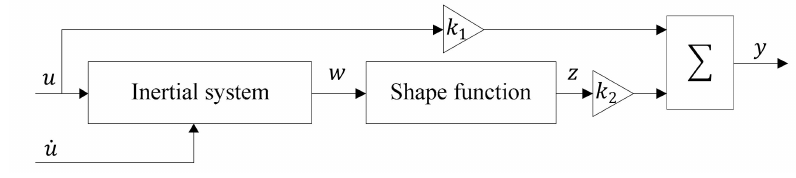
Figure 3. The proposed ISSF-Duhem